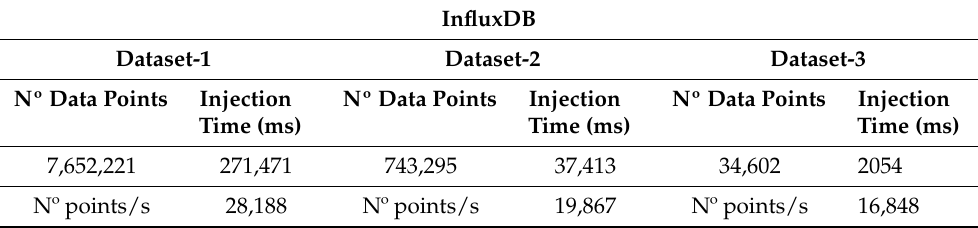
Table 4. Data Injection through InfluxDB.